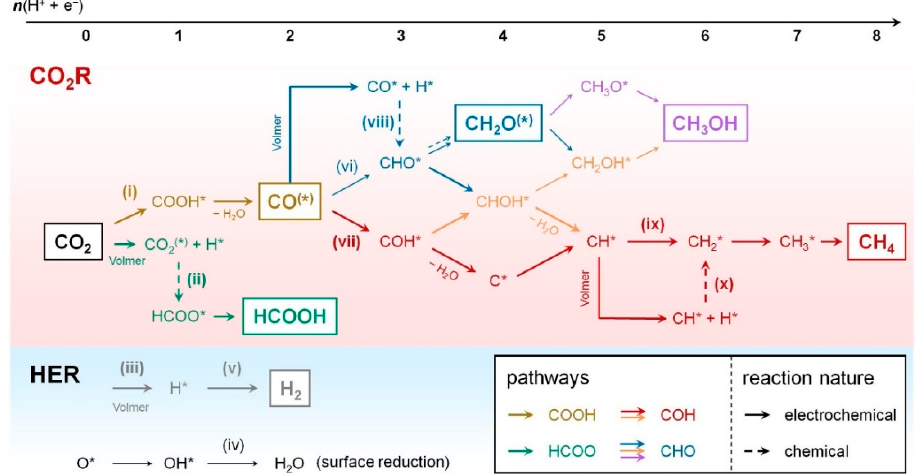
Figure 2. Scheme of the reaction pathways and key intermediates for different CO 2 electroreduction products. Reproduced with permission [32]. HER: hydrogen evolution reaction.